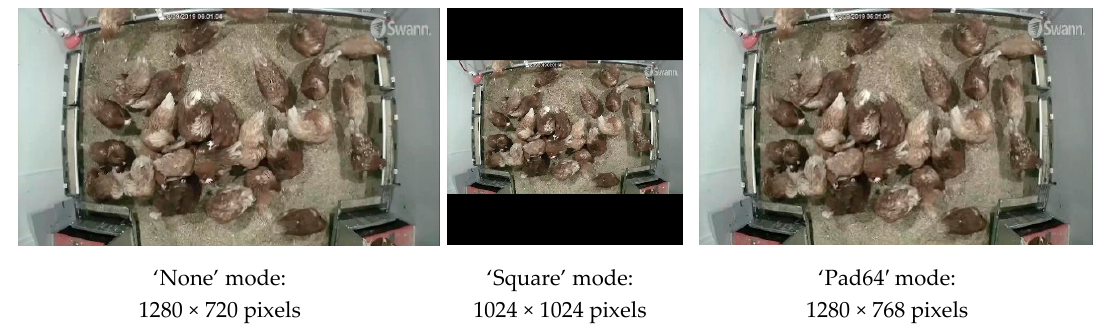
Figure 6. Resized sample images with three modes of image Figure 6. R esized sample images with three modes of image resizers.